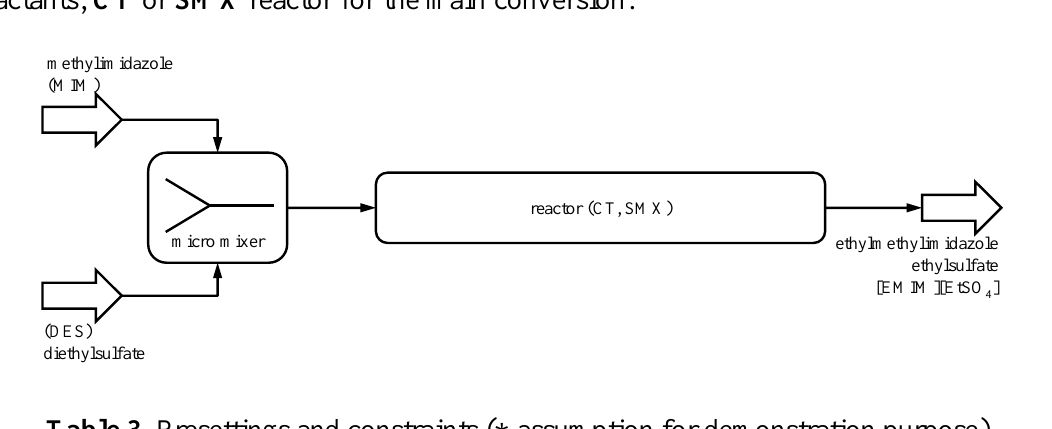
Table 3. Presettings and constraints (* assumption for demonstration purpose).